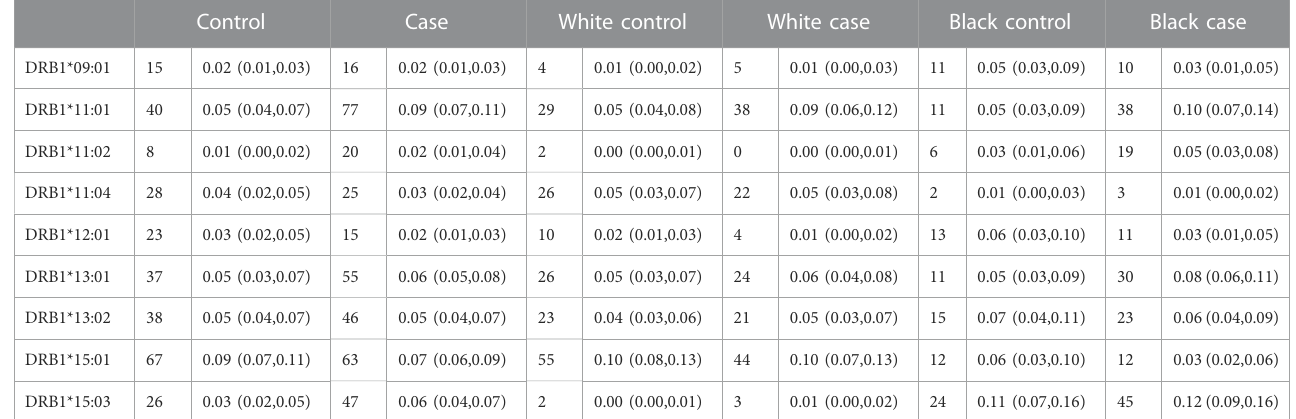
(Table 4). Thereafter, and knowing the different residues of